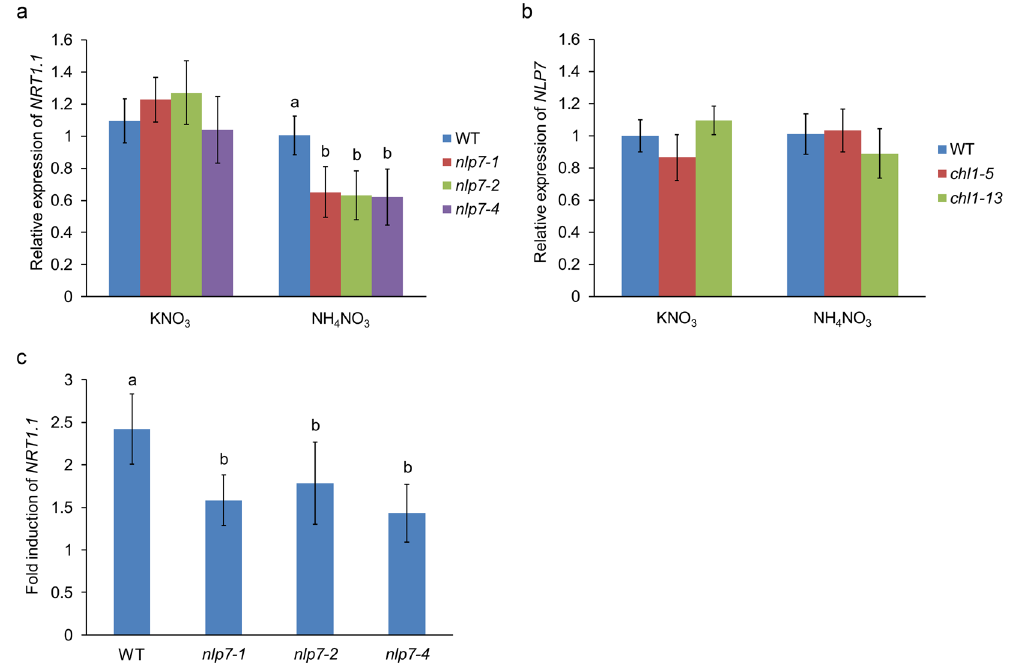
Figure 1. The transcript levels of NRT1.1 in the nlp7 plants were reduced when NH 4 + is present. ( a ) Relative expression of NRT1.1 in WT and the nlp7 plants. Seedlings were planted on medium containing 10 mM potassium nitrate or 10 mM ammonium nitrate for 7d for testing NRT1.1 ′ s expression. Error bars mean ± SD of four biological replicates. The significant difference ( p < 0.05, t test) is indicated by different letters. ( b ) Relative expression of NLP7 in WT and the chl1 mutants. The growth conditions of plants are the same as ( a ). Error bars mean ± SD of four biological replicates. ( c ) Nitrate response of NRT1.1 in WT and the nlp7 mutants. Seedlings were planted on medium with 2.5 mM ammonium succinate for 7d, then treated with 10 mM KNO 3 or KCl for 2 h followed by collecting samples for detecting nitrate induction of NRT1.1 . Error bars mean ± SD of four biological replicates. The significant difference ( p < 0.05, t test) is indicated by different